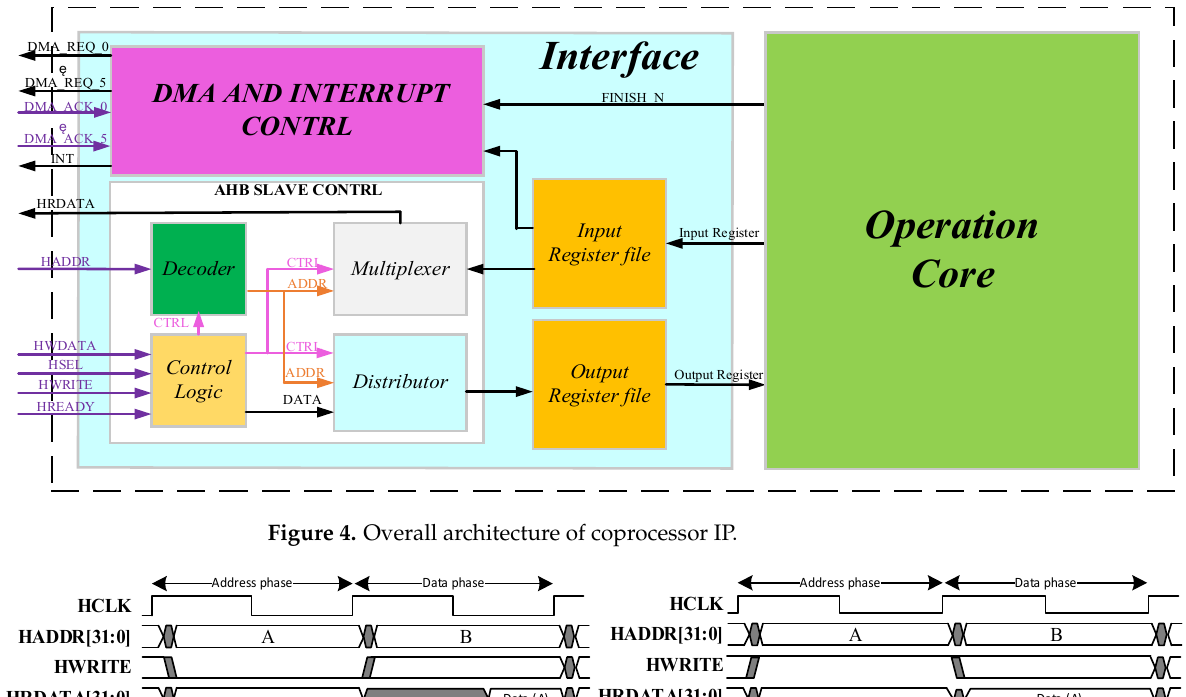
Figure 5. The read and write operations of the AHB protocol in the basic transmission mode.